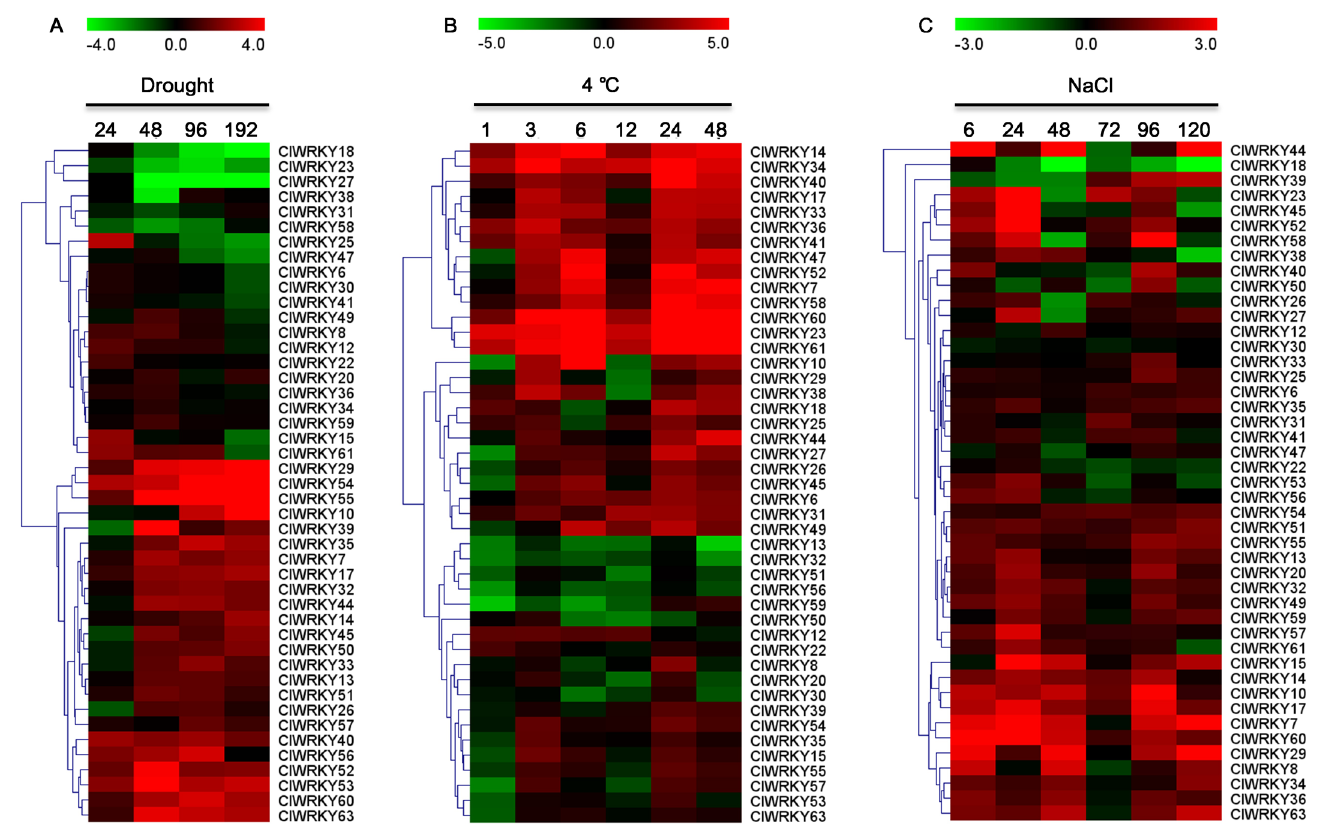
Fig 8. Expression patterns of ClWRKY genes under abiotic stresses by qRT-PCR. The abiotic stresses used for expression patterns are indicated at the top. Scale bars on the top of each heat map represent log 2 -transformed (Treatment/Control) values, with red as increased expressed level and green as decreased expressed level. (A) Expression of ClWRKY genes under drought stress, and 24, 48, 96, and 192 indicate hours after treatment. (B) Expression of ClWRKY genes under 4˚C treatment, and 1, 3, 6, 12, 24, and 48 indicate hours after treatment. (C) Expression of ClWRKY genes under salt stress treatment, and 6, 24, 48, 72, 96, and 120 indicate hours after